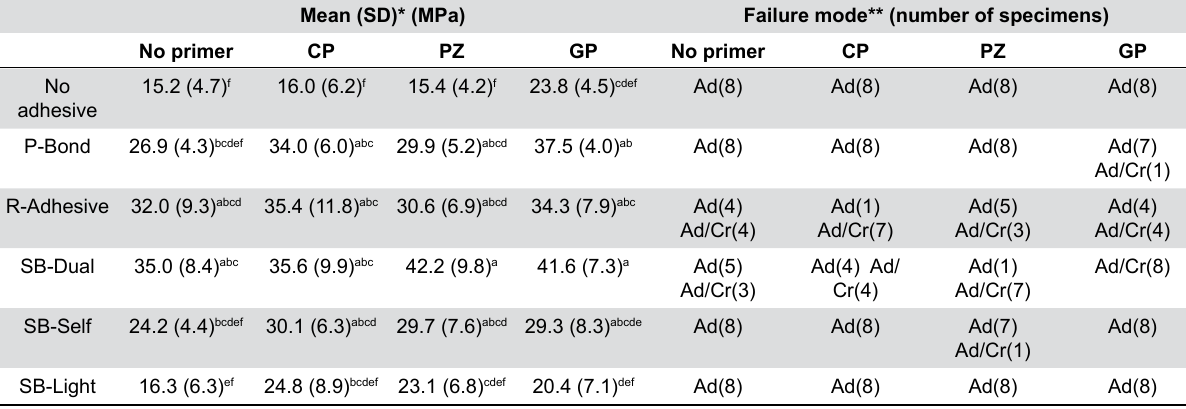
Table 2- Shear bond strengths and failure modes observed after shear bond testing